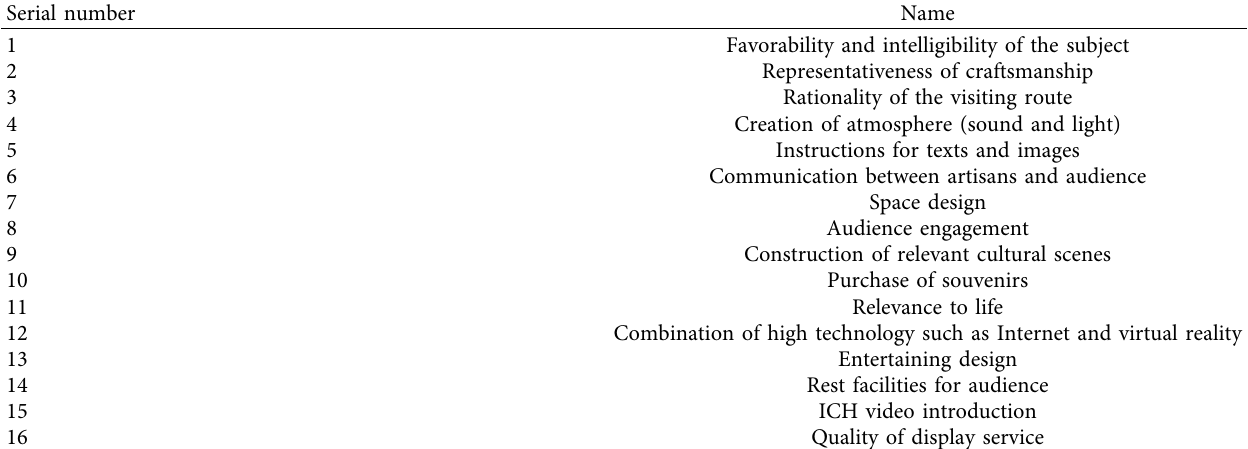
Table 2: Key aspects of audience satisfaction with ICH display